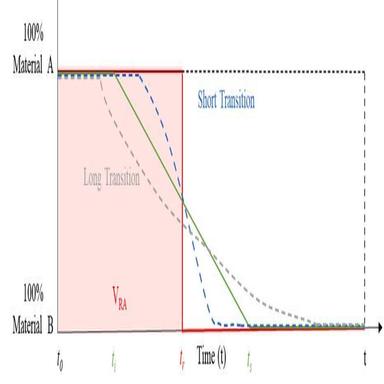
A schematic depicting the change in composition over an arbitrary Time, t. The shaded red square, VRA, represents the volume of residual Material A remaining in the barrel of the extruder. The solid lines represent theoretical Step (Red) and Linear (Green) functions. The two dotted lines represent the possible nonlinear transitions (For interpretation of the references to color in this figure legend, the reader is referred to the web version of this article).